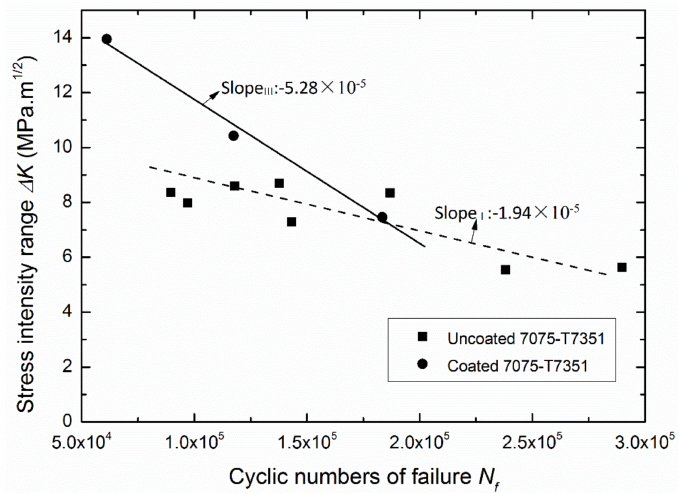
Figure 4. Relationship between ∆ K and cyclic numbers of failure in air for uncoated and coated 7075-T7351 Al